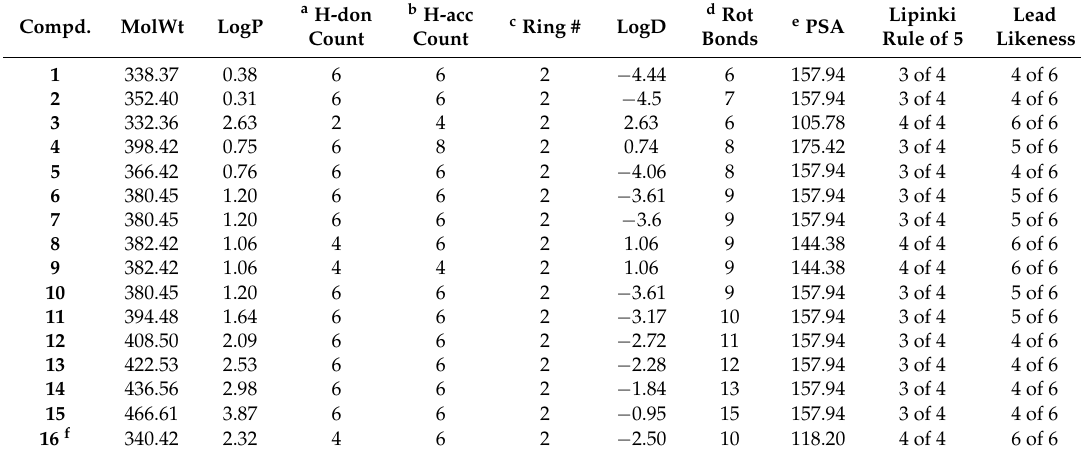
Table 2. Calculated physicochemical properties, Lipinski rule of 5 and lead